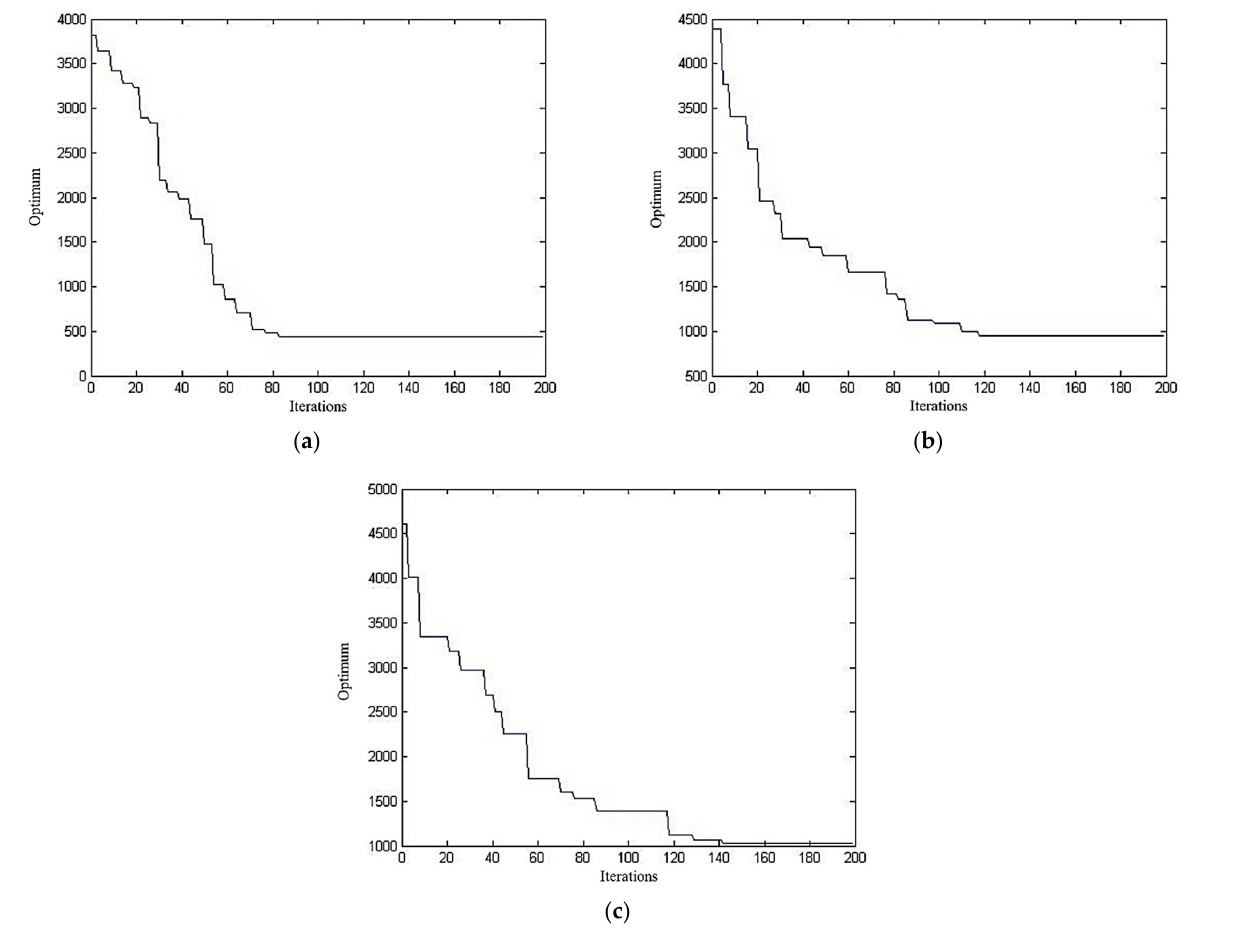
Figure 7. Iteration graph to obtain optimum for EVRPTW-DC: ( a ) 81 iterations for Scenario 1; ( b ) 119 iterations for Scenario 2; ( c ) 141 iterations for Scenario 3.